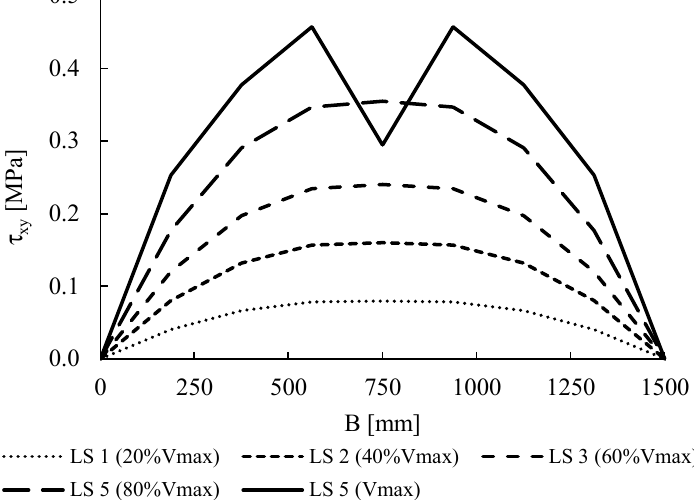
Figure 16. Shear stress distribution along the middle cross-section of the wall for the case 1.6 at different load steps (LS).